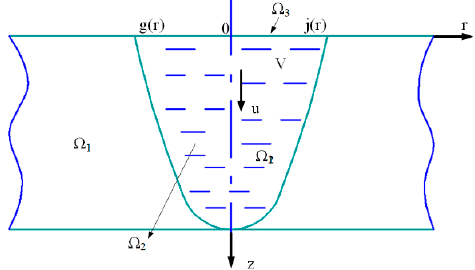
Figure 5. Macrostructure of the welded joint of the prototype rotor.